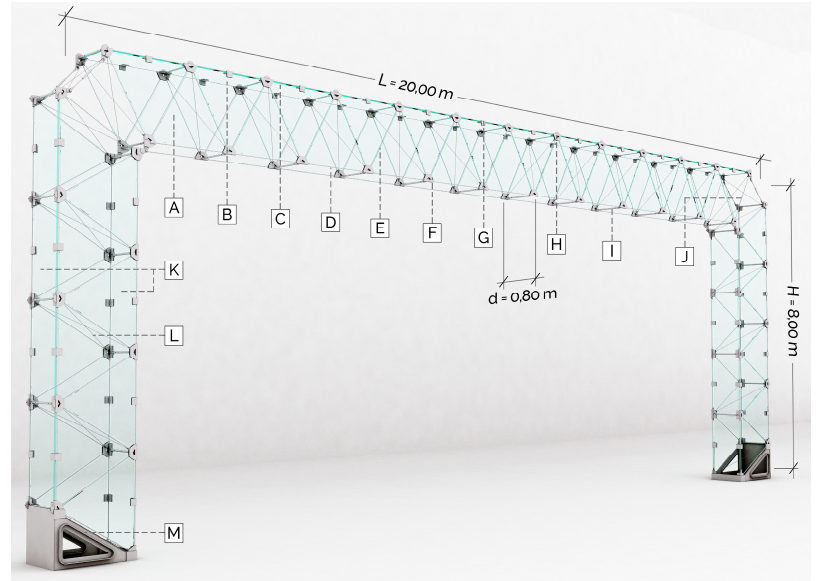
Figure 5. TVT γ -bis frame portal: A—triangular vertical glass panel of the beam (1500 mm side, 10 + 1.52 + 10 mm thickness); B—rectangular outer glass panel of the beam (724 × 1497 mm, 10 + 1.52 + 10 mm thickness); C—outer pre-stressed longitudinal strand Ø11.3 mm; D—inner pre-stressed longitudinal strand Ø11.3 mm; E—diagonal pre-stressed longitudinal strand Ø9.3 mm; F—four-way inner steel node; G—intermediate steel node; H—four-way outer steel node, connection of the bracing panels; I—transversal steel tube; J—beam-to-column joint; K—rectangular glass flange of the column (724 × 1497 mm, 10 + 1.52 + 10 mm thickness); L—pre-stressed diaphragm; M—column-to-base